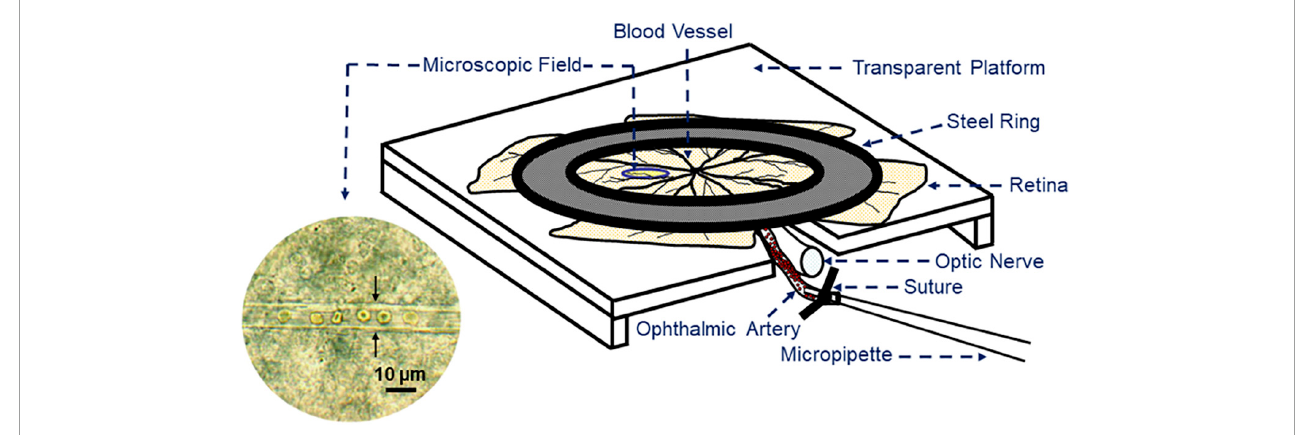
FIGURE5 Sketch of the retinal preparation for retinal blood vessel reactivity measurement by transmitted light microscopy. An isolated retina with the optic nerve and the ophthalmic artery is fixed on a transparent plastic platform by a steel ring. To pressurize the retinal vasculature, the ophthalmic artery is cannulated with a micropipette, which is connected to a reservoir filled with buffer solution. In the microscopic field, a retinal arteriole with luminal red blood cells is visible. The arrows point to the vascular